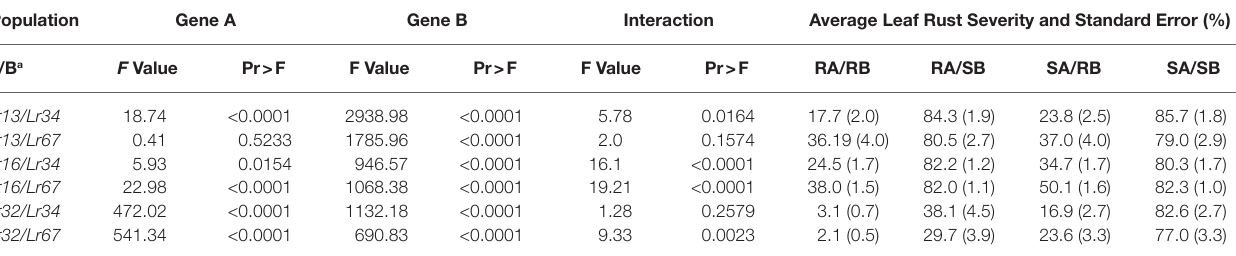
TABLE 1 | Effect of each gene and their interaction on the severity of leaf rust and the average severity for each genotypic class. Population Gene A Gene B